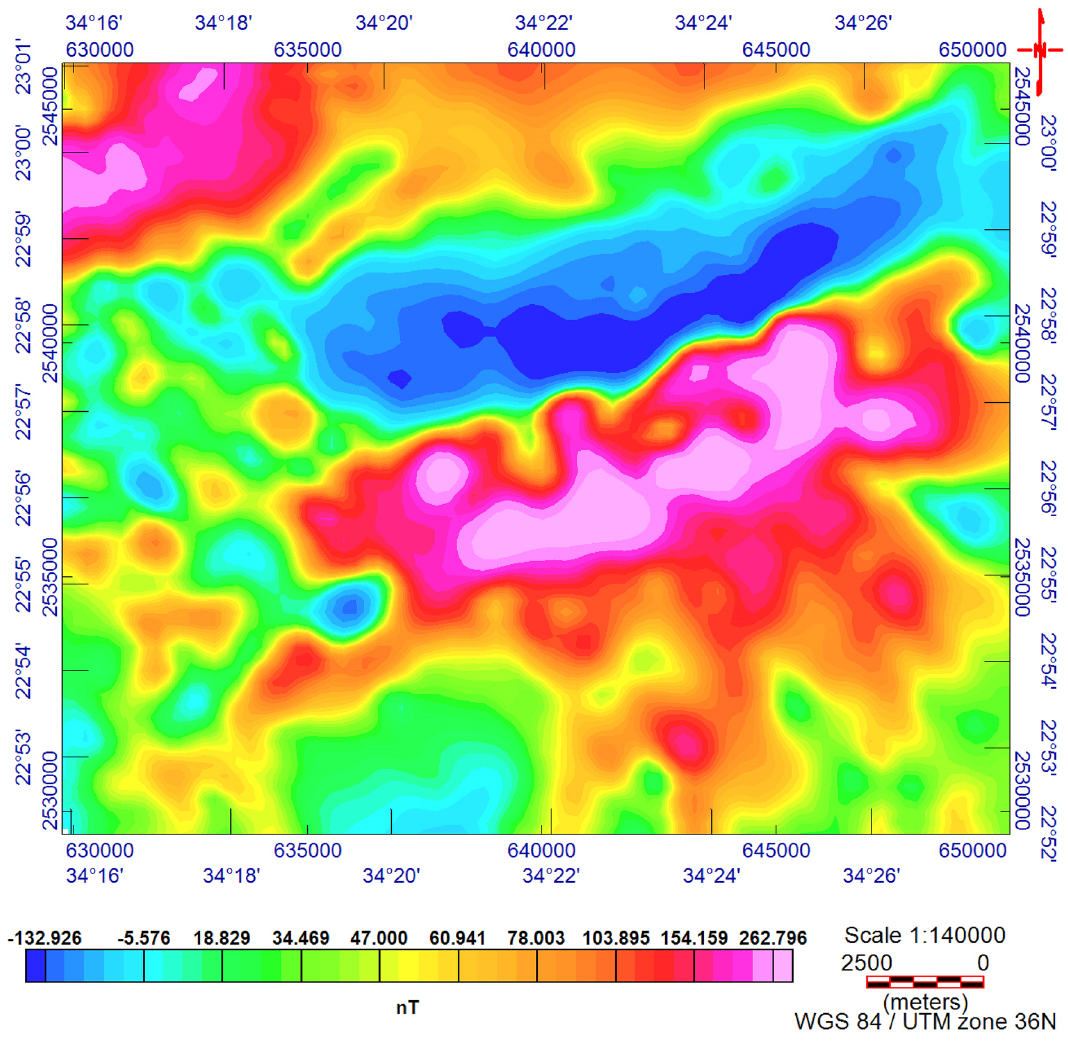
Figure 3. Total magnetic intensity map of the study area 55